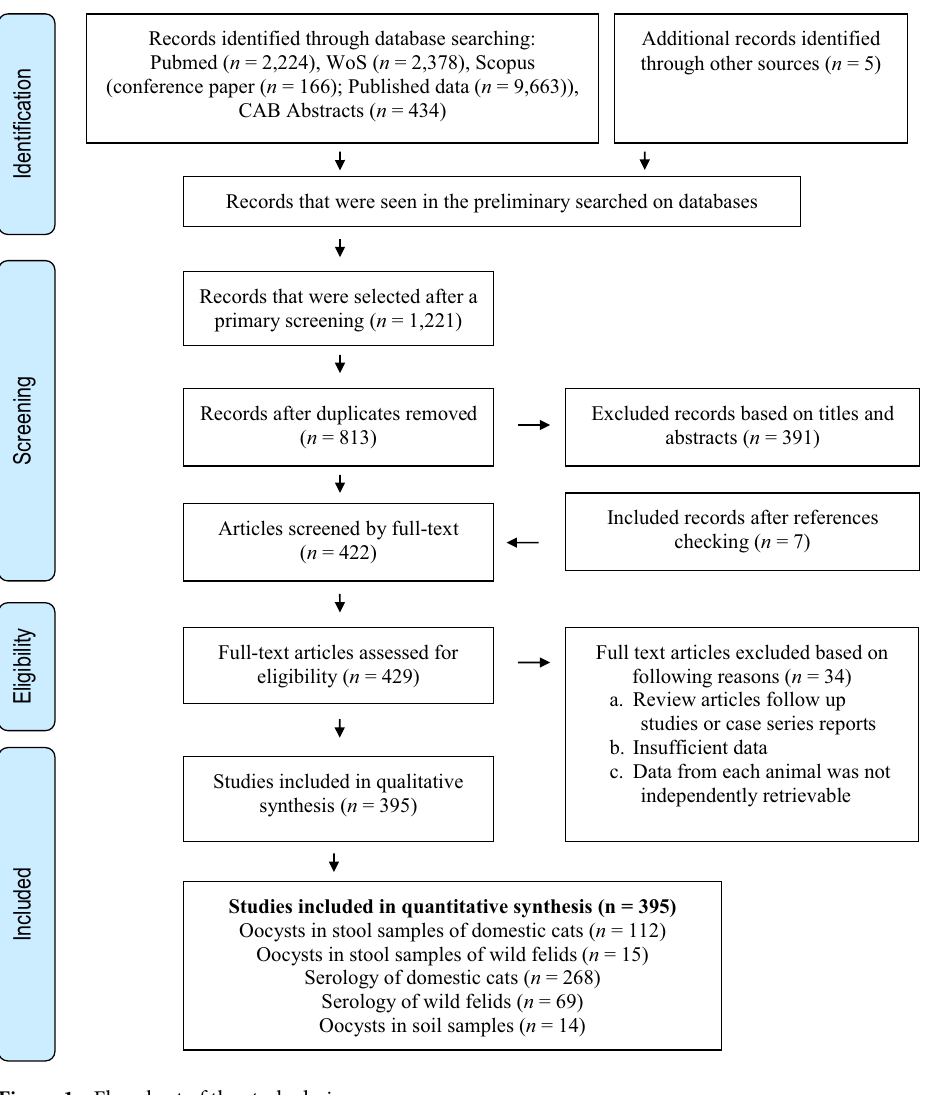
Figure 1. Flowchart of the study design